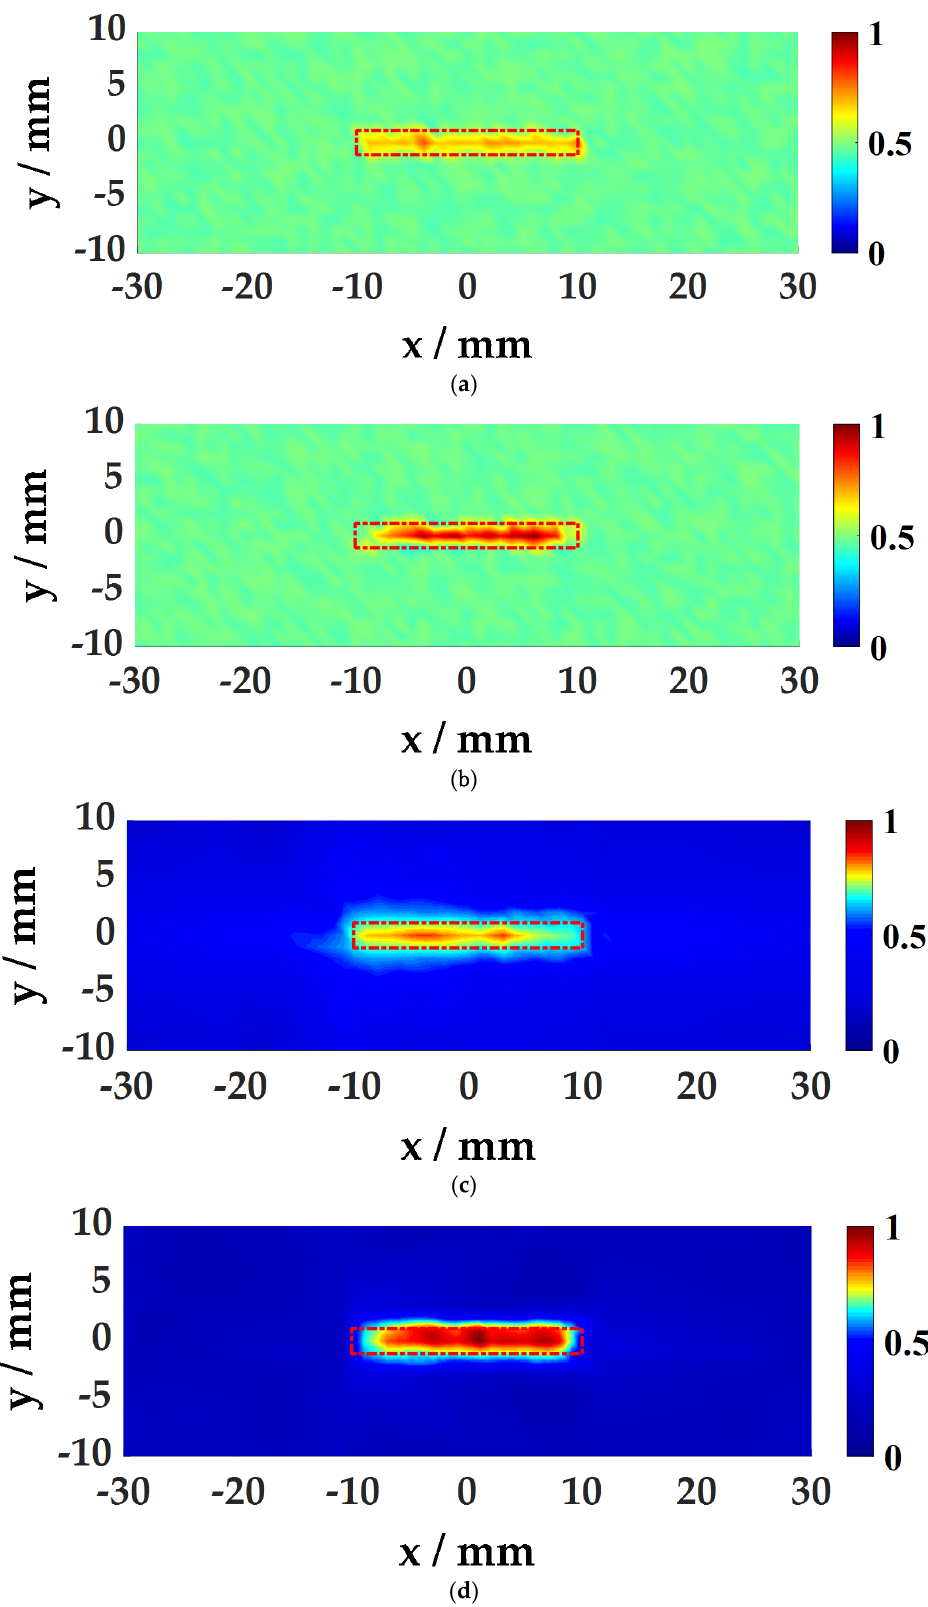
Figure 13. Damage Imaging results of the CERP plate: ( a ) Imaging of damage at 1 mm depth using the WFA; ( b ) Imaging of damage at 1.5 mm depth using the WFA; ( c ) Imaging of damage at 1 mm depth using the SWA; ( d ) Imaging of damage at 1.5 mm depth using the